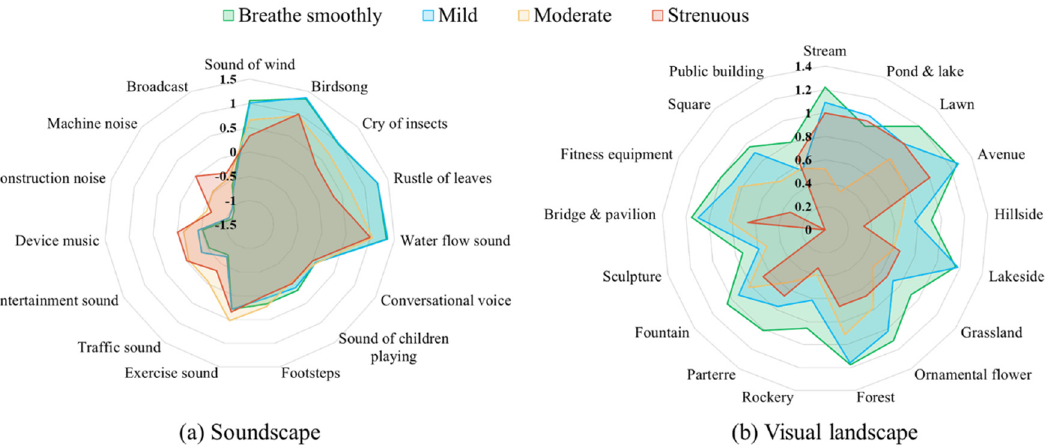
Figure 11. Radar map of soundscape ( a ) and visual landscape ( b ) preferences distribution of exercisers at different exercise intensity.